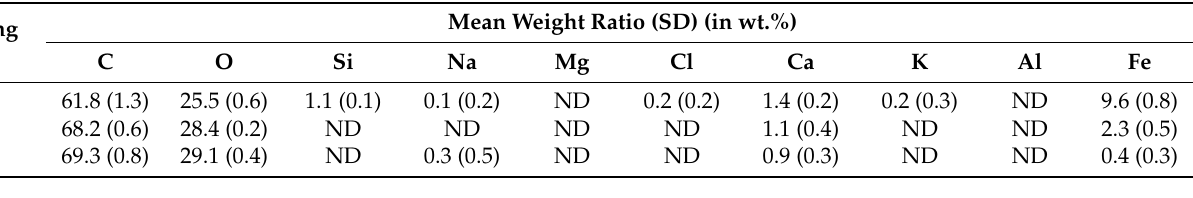
Table 5. Weight ratio for each major element of the return air, measured using SEM-EDS, on 23 May. Mean Weight Ratio (SD) (in wt.%) Sampling Area